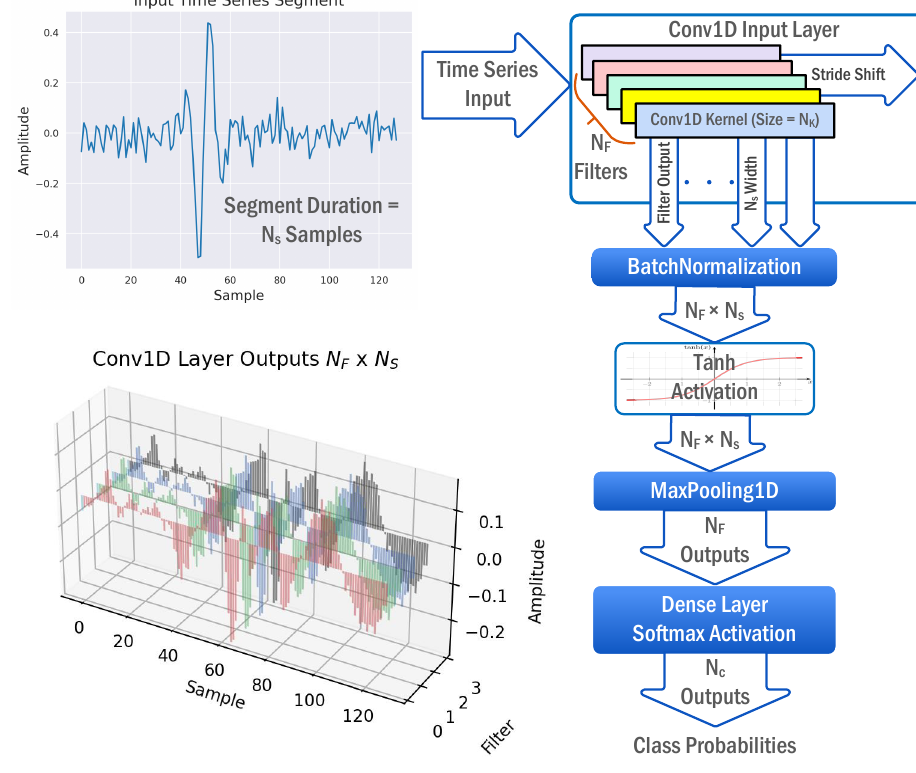
Figure 2. The MF CNN classifier